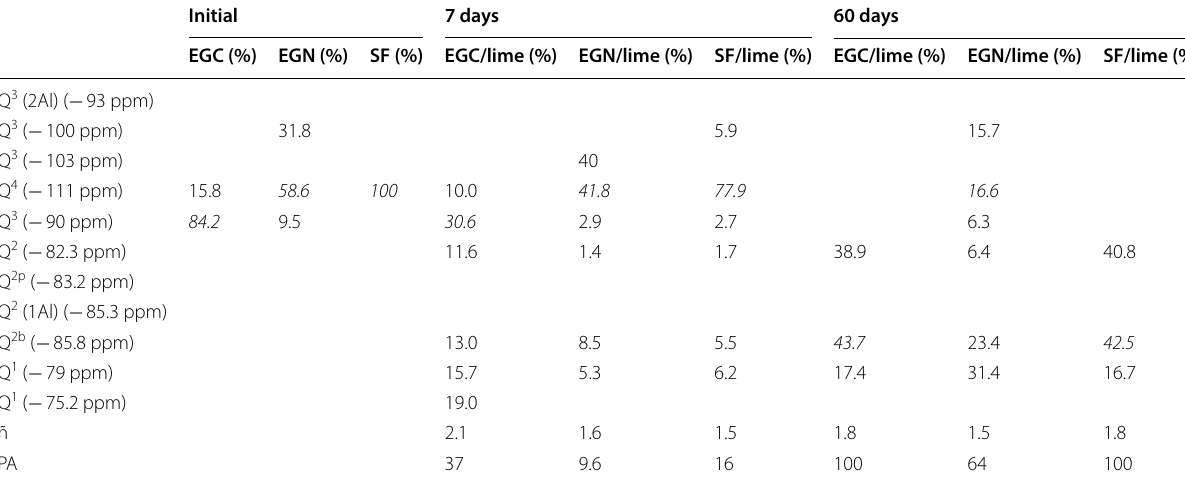
Obs. the higest band in each column is showed in